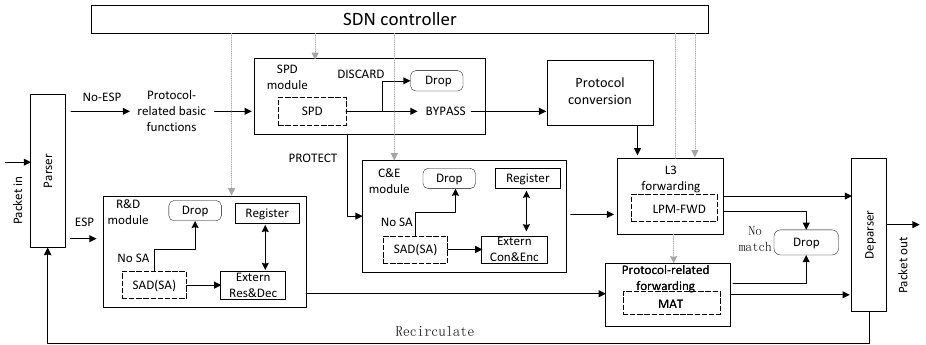
Figure 4. The processing flow of MultiSec in the data plane.